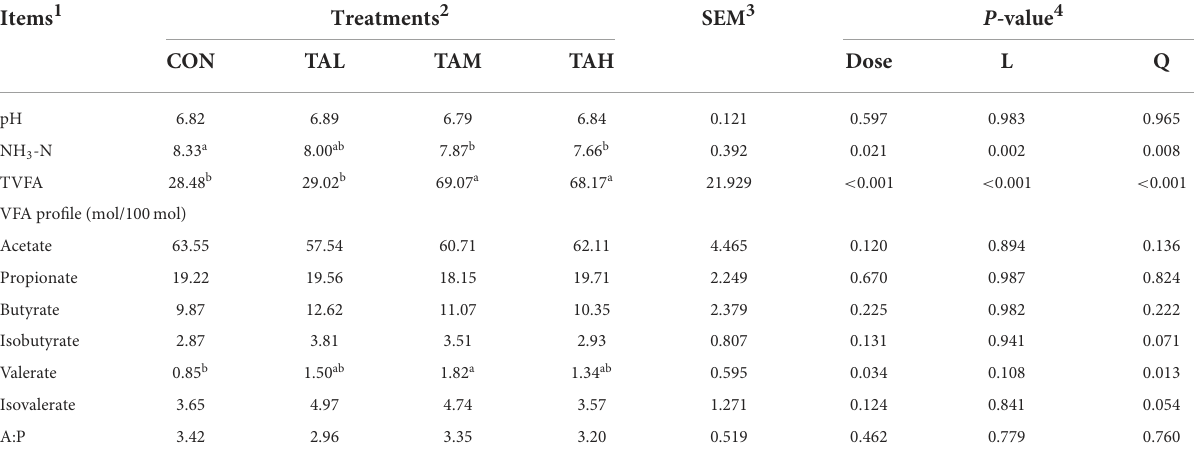
TABLE 3 Effects of tannic acid at different doses on rumen fermentation characteristics of black goats.